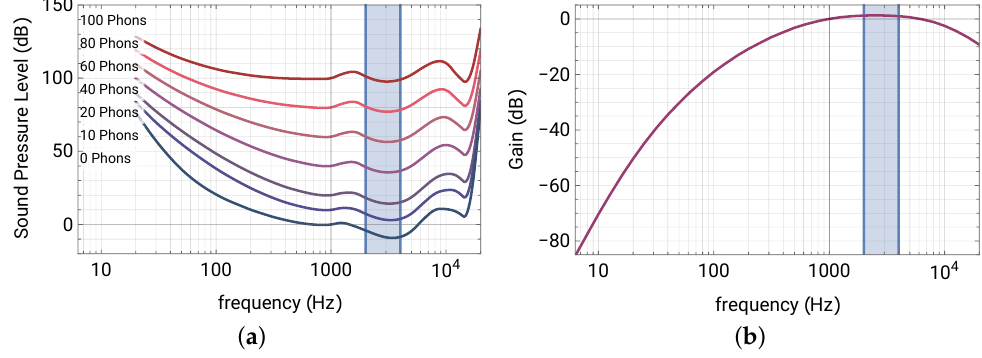
Figure 1. ( a ) Equal loudness contours (ISO 226). Dips around 2–4 kHz indicate the increase of hearing sensitivity to sound pressure. ( b ) The dBA weighting curve (ANSI S1.42) accounting for equal